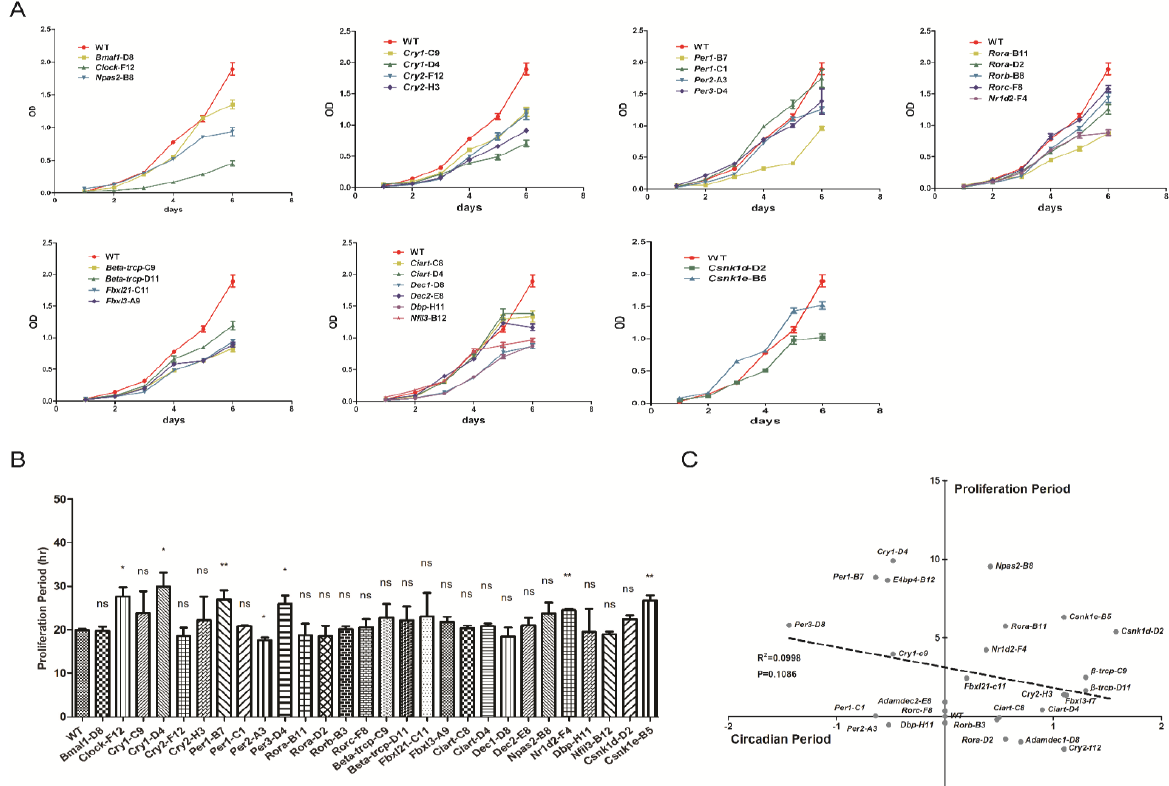
Figure 5. The proliferation periods of clock gene mutant cells are not correlated with their circadian periods. ( A ) Cell proliferation curves of wild-type and clock gene deletion monoclonal cell lines for six consecutive days. ( B ) The proliferation period of each cell line was calculated and plotted. ( C ) The relationship between the circadian period changes and the proliferation period of the monoclonal cell lines. Linear relationship was applied to fit the data in panel C. Results are expressed as mean ± SD. n ≥ 3 in each group. ns, no significant, * p < 0.05, ** p < 0.01.